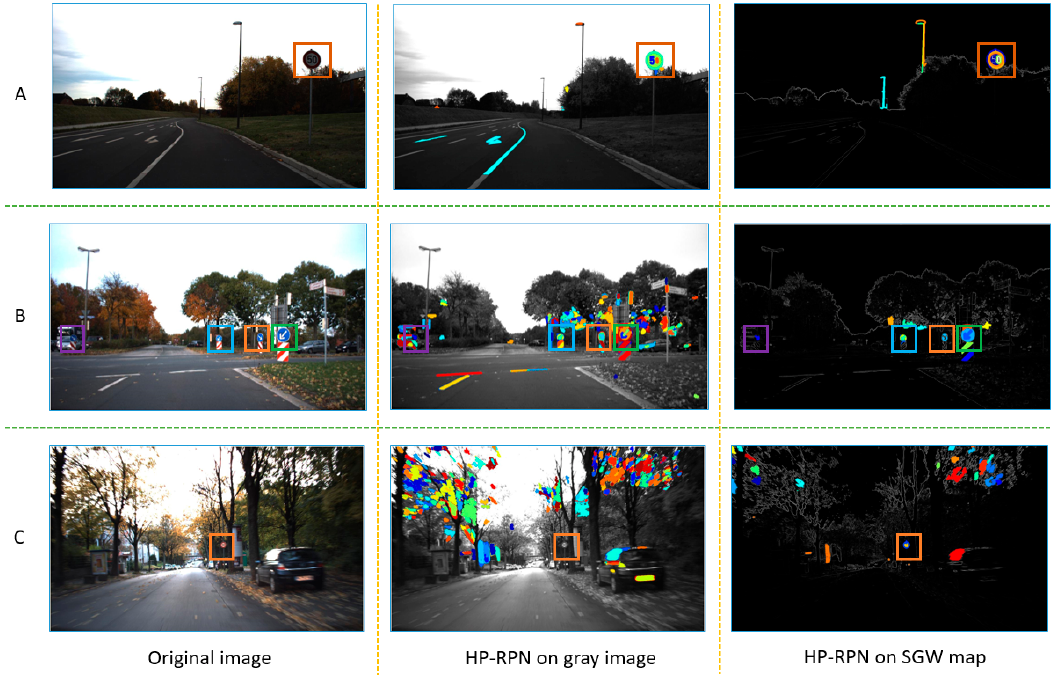
Figure 11. Examples of regions proposal by the highly possible regions proposal network (HP-RPN) on a grayscale image and the HP-RPN on an SGW feature map under different situations of traffic scenes. ( A ): clear and simple traffic scene, ( B ): complex traffic scene, ( C ): motion blurred complex traffic scene.